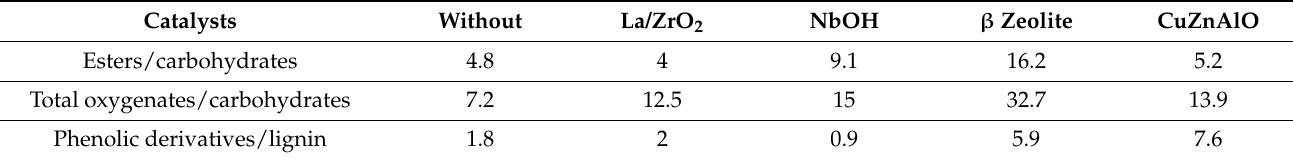
Table 4. Yields of chemicals relative to their original wood